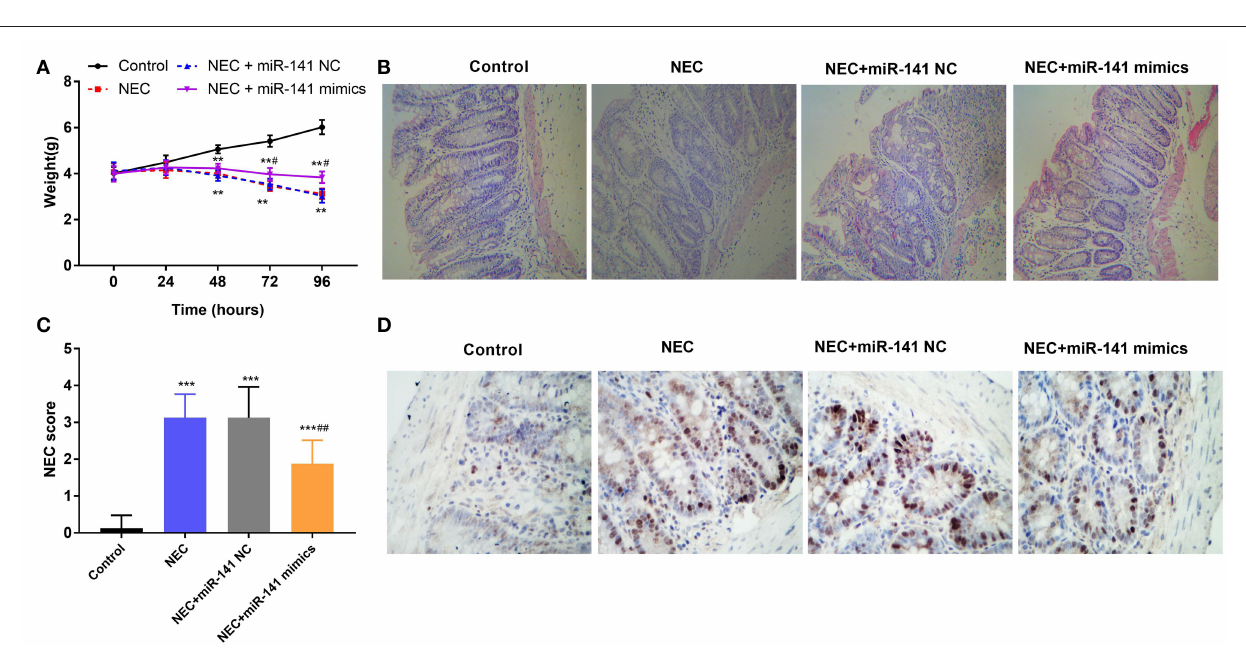
group was increased as contrasted with the Control group ( P < 0.001). Inversely, overexpressed miR-141-3p decreased the NEC score ( P < 0.001, Figure 2C ). Furthermore, TUNEL staining revealed apoptosis of intestinal epithelial cells. Microscopically, we noted that a large number of cell nuclei were blue in the NEC group, which presented strong positive. But partial cell nuclei were blue in the NEC + miR-miR-141 mimics group, which exhibited as positive ( Figure 2D ). These observations hinted that miR-141-3p distinctly inhibited cell apoptosis. In a word, the above results showcased that miR-141-3p could mitigate the damage to intestinal tissues of